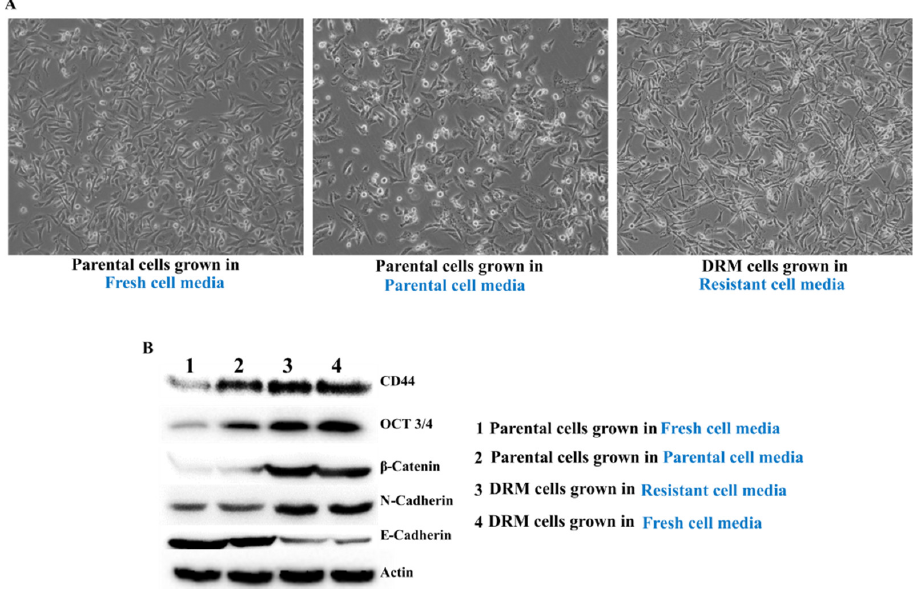
Figure 9. Autocrine signaling in maintaining DRM cells. The parental cells were grown in resistant cell media showed an almost similar pattern of DRM cells in terms of the expression of CSC and EMT phenotype. Parental- MDA-MB-231 cells were grown in Doxorubicin-resistant cells grown media. ( A ) Morphological analysis of Parental- MDA-MB-231 cells, Parental- MDA-MB-231 cells grown in Doxorubicin resistant cells grown media. ( B ) Western blot analysis of autocrine signaling by analyzing the cancer stem cell markers and EMT phenotype. Results were confirmed by three independent experiments. DRM: Doxorubicin-resistant MDA-MB-231.